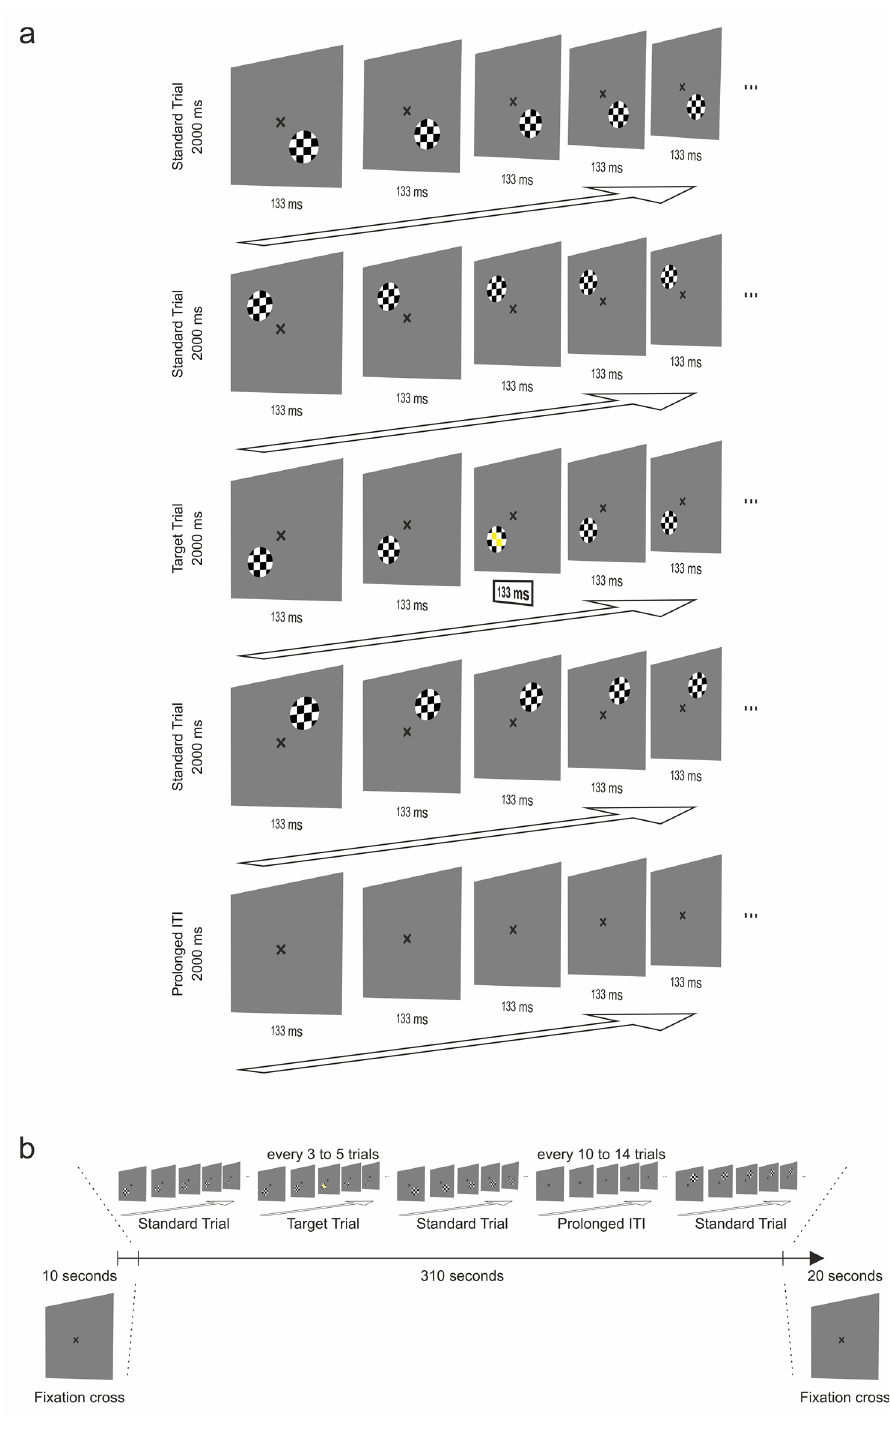
Figure 5. Visual field localizer paradigm. ( a ) The paradigm consisted of flickering, black-and-white colored checkerboards that appeared randomly at homologous positions of the participant’s visual quadrant. In 25% of the trials, the two centrally located squares changed their color to yellow for 133 ms. Participants were required to press a response box button when noticing that. Participants were instructed to continuously fixate a black, x-shaped fixation cross presented at the center of the screen. Checkerboards appeared for 2000 ms. The regular inter-trial interval (ITI) was 0 ms. ( b ) Every 10–14 trials, the ITI extended to 2000 ms. The task comprised 144 trials (25% target trials). It was preceded and followed by a presentation of the fixation cross for 10